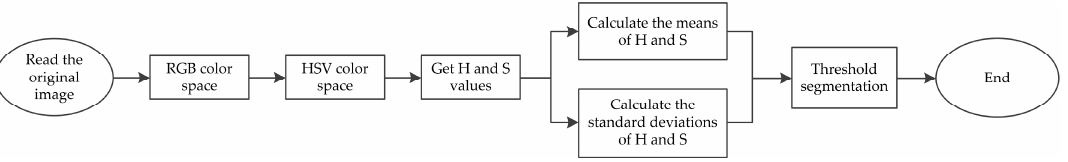
Figure 3. The color space threshold segmentation step diagram.